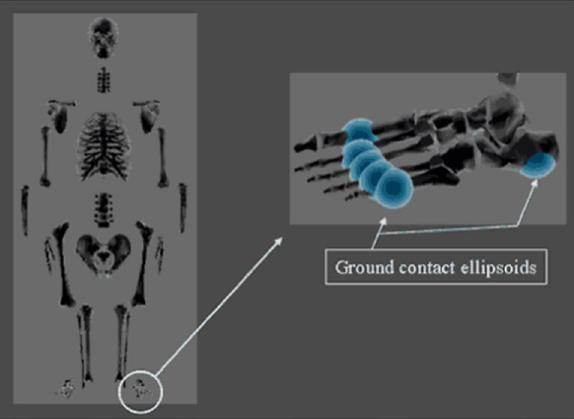
Fig. 1 LifeMod Human Body 19 Link Model (LifeMod Hand- book,